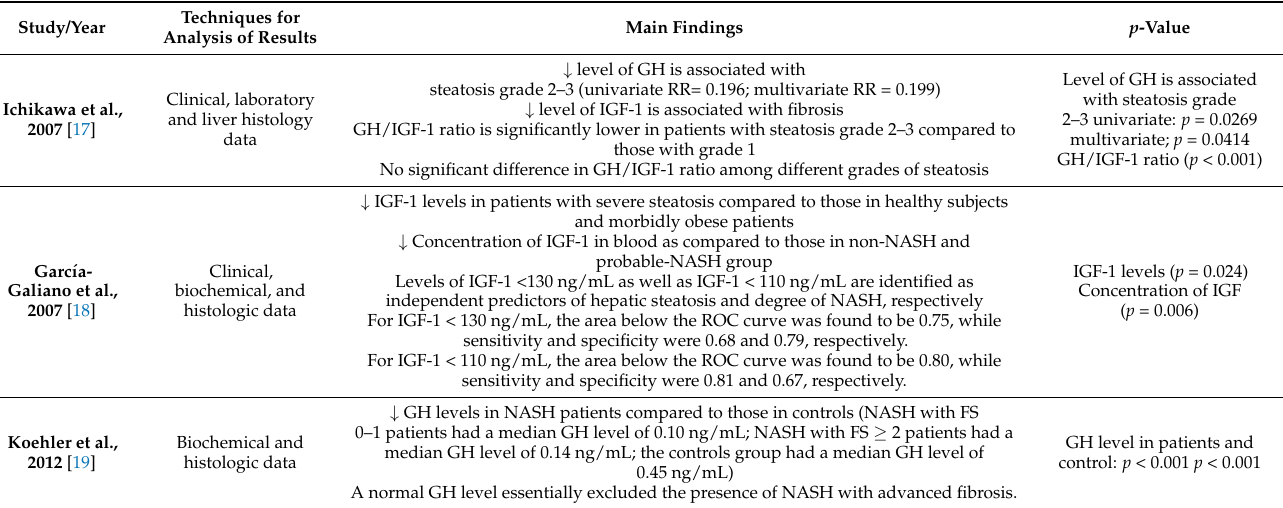
Table 3. Main findings of human